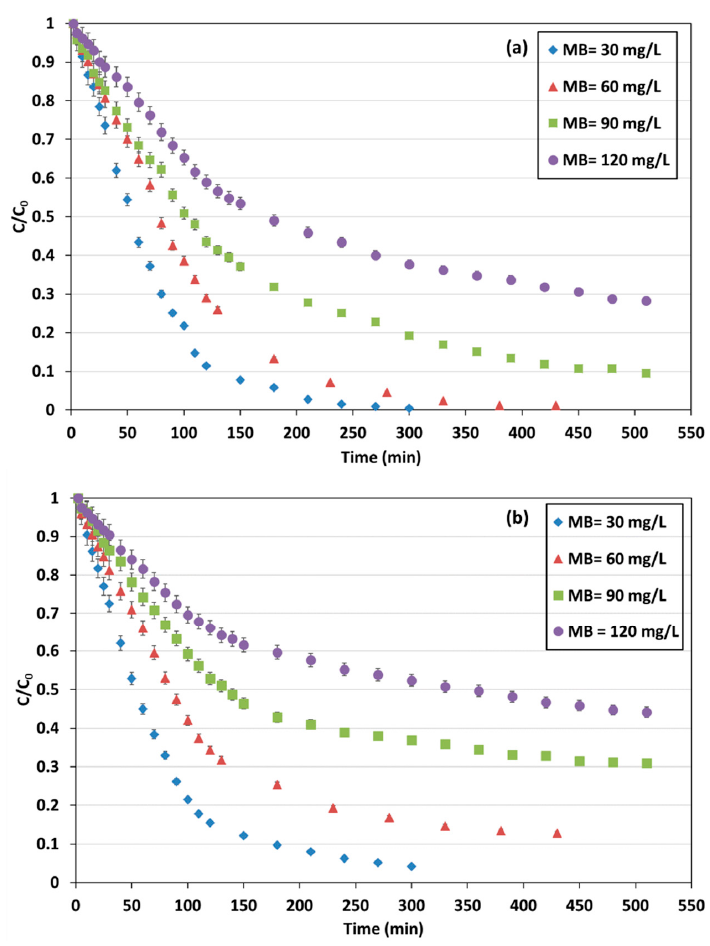
Figure 10. Aqueous solution COT variation for MB degradation under UV-irradiation for ( a ) low (30 mg/L) and ( b ) high (120 mg/L) zinc concentrations (C 0, MB = 30–120 mg/L, pH neutral, D TiO2 = 1 g/L; temperature = 20 ± 2 °C).